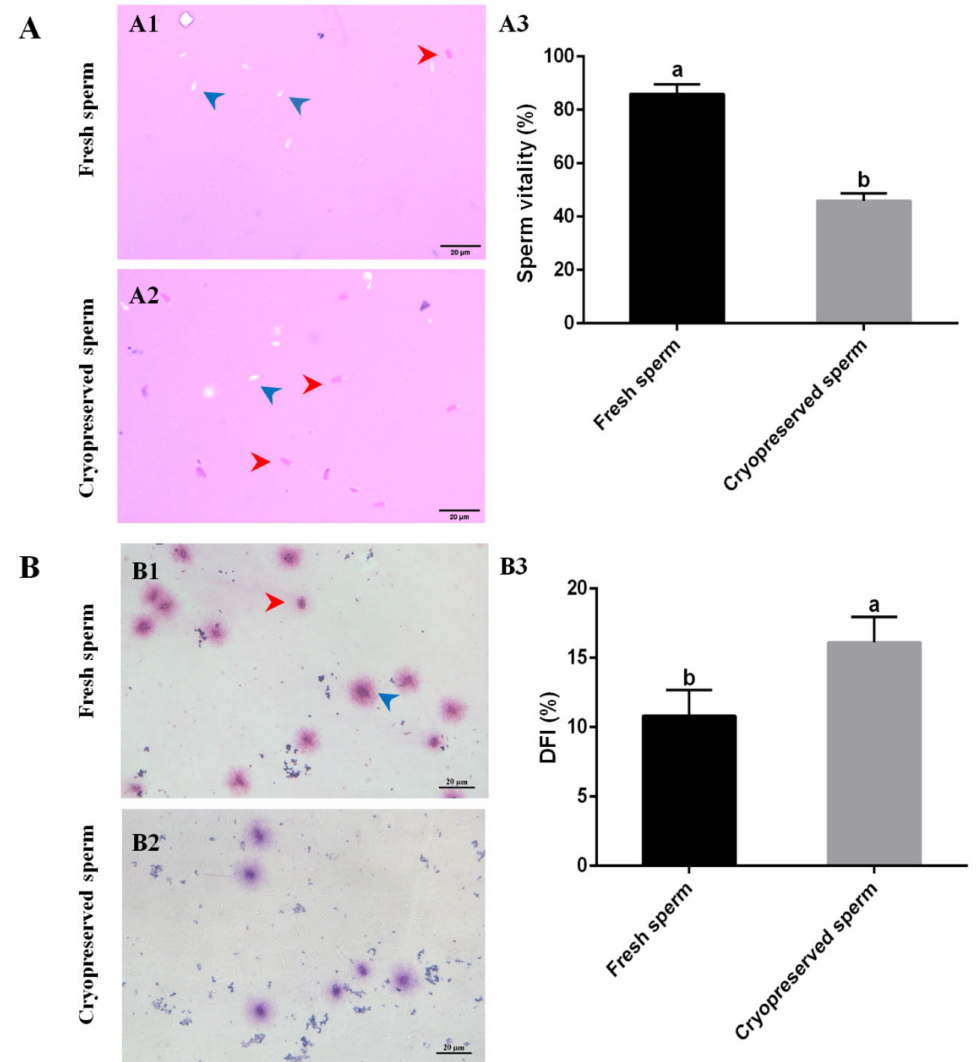
Figure 2. Effects of cryopreservation on sperm quality with the cryodiluent (FBS + 15% Gly). ( A ) Effects of cryopreservation on sperm plasma membrane integrity. ( A1 , A2 ) the eosin-aniline black staining. The dead sperm with damaged plasma membrane were stained to dark pink, whereas live sperm with plasma membrane integrity were not stained. ( A3 ) Vitality of fresh and cryopreserved sperm. Sperm vitality measured as % of sperm without staining. ( B ) Effects of cryopreservation on sperm DNA integrity. ( B1 , B2 ) sperm chromatin dispersion (SCD) test. The sperm without fragmented DNA showed nucleoids with big halos of spreading of DNA loops, whereas those with fragmented DNA showed no halo or a small halo. ( B3 ) DFI of fresh and cryopreserved sperm. DFI measured as % of sperm with no halo or a small halo. Scale bar = 20 µ m. Statistical significance was accepted when p < 0.05 and indicated by different